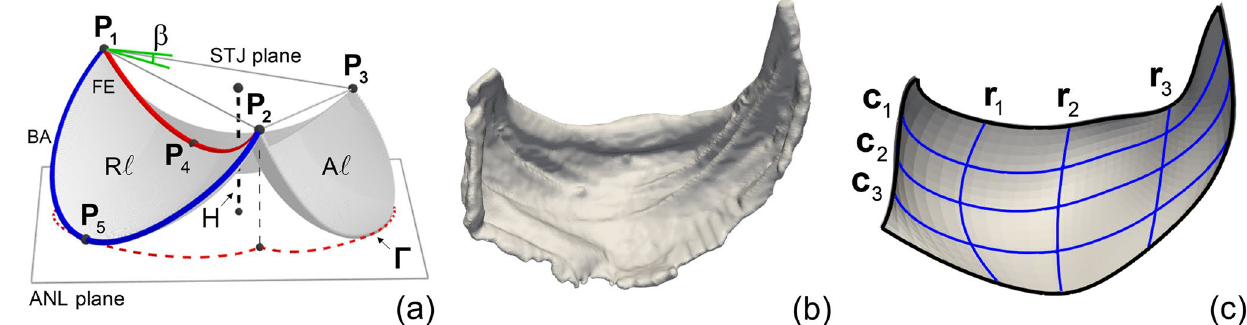
Figure 2. Analysis of the µCT image of individual leaflets. ( a ) schematic for the geometry of a murine PV and key geometric quantities of interest, ( b ) segmented µCT image of a single leaflet, ( c ) NURBS fitted mid-surface of the leaflet and cross sections in the circumferential and radial directions. The curves c 2 and r 2 represent the central cross sections of the leaflet in which r 2 are chosen to pass through the mid-point of the free edge P 4 .